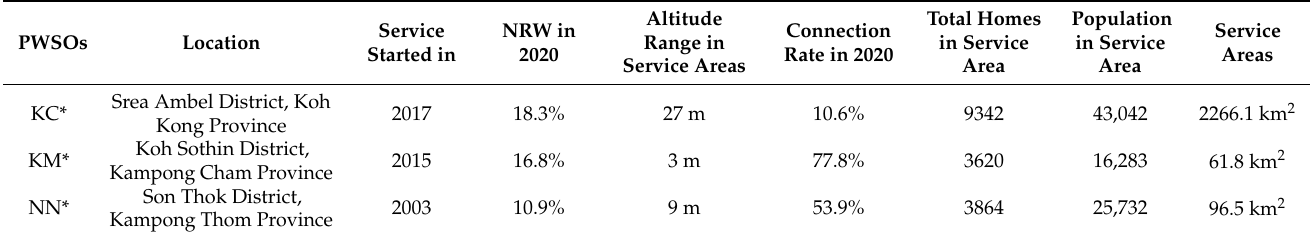
Table 2. Description of the three PWSOs in this